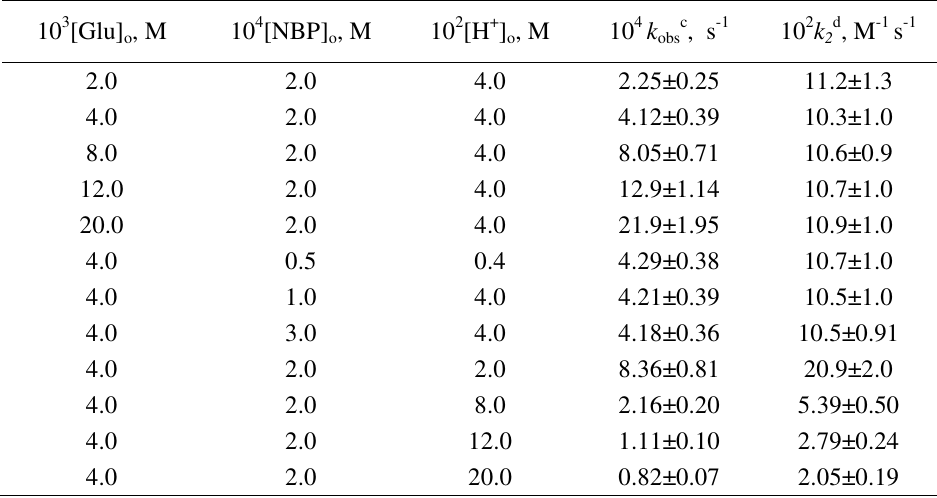
Table 1. Pseudo first-order and second-order rate constants for the oxidation of glutamic acid by NBP in aqueous perchloric acid at 303 K a,b